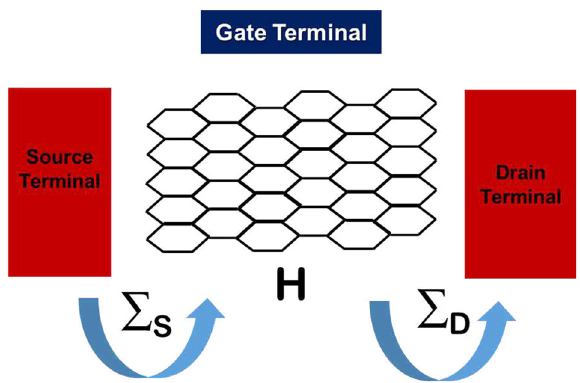
Fig. 3 Generic NEGF Framework for Nano Transistors. Schematic representation of nanoscale 2D-TFET under NEGF-based quantum transport framework.